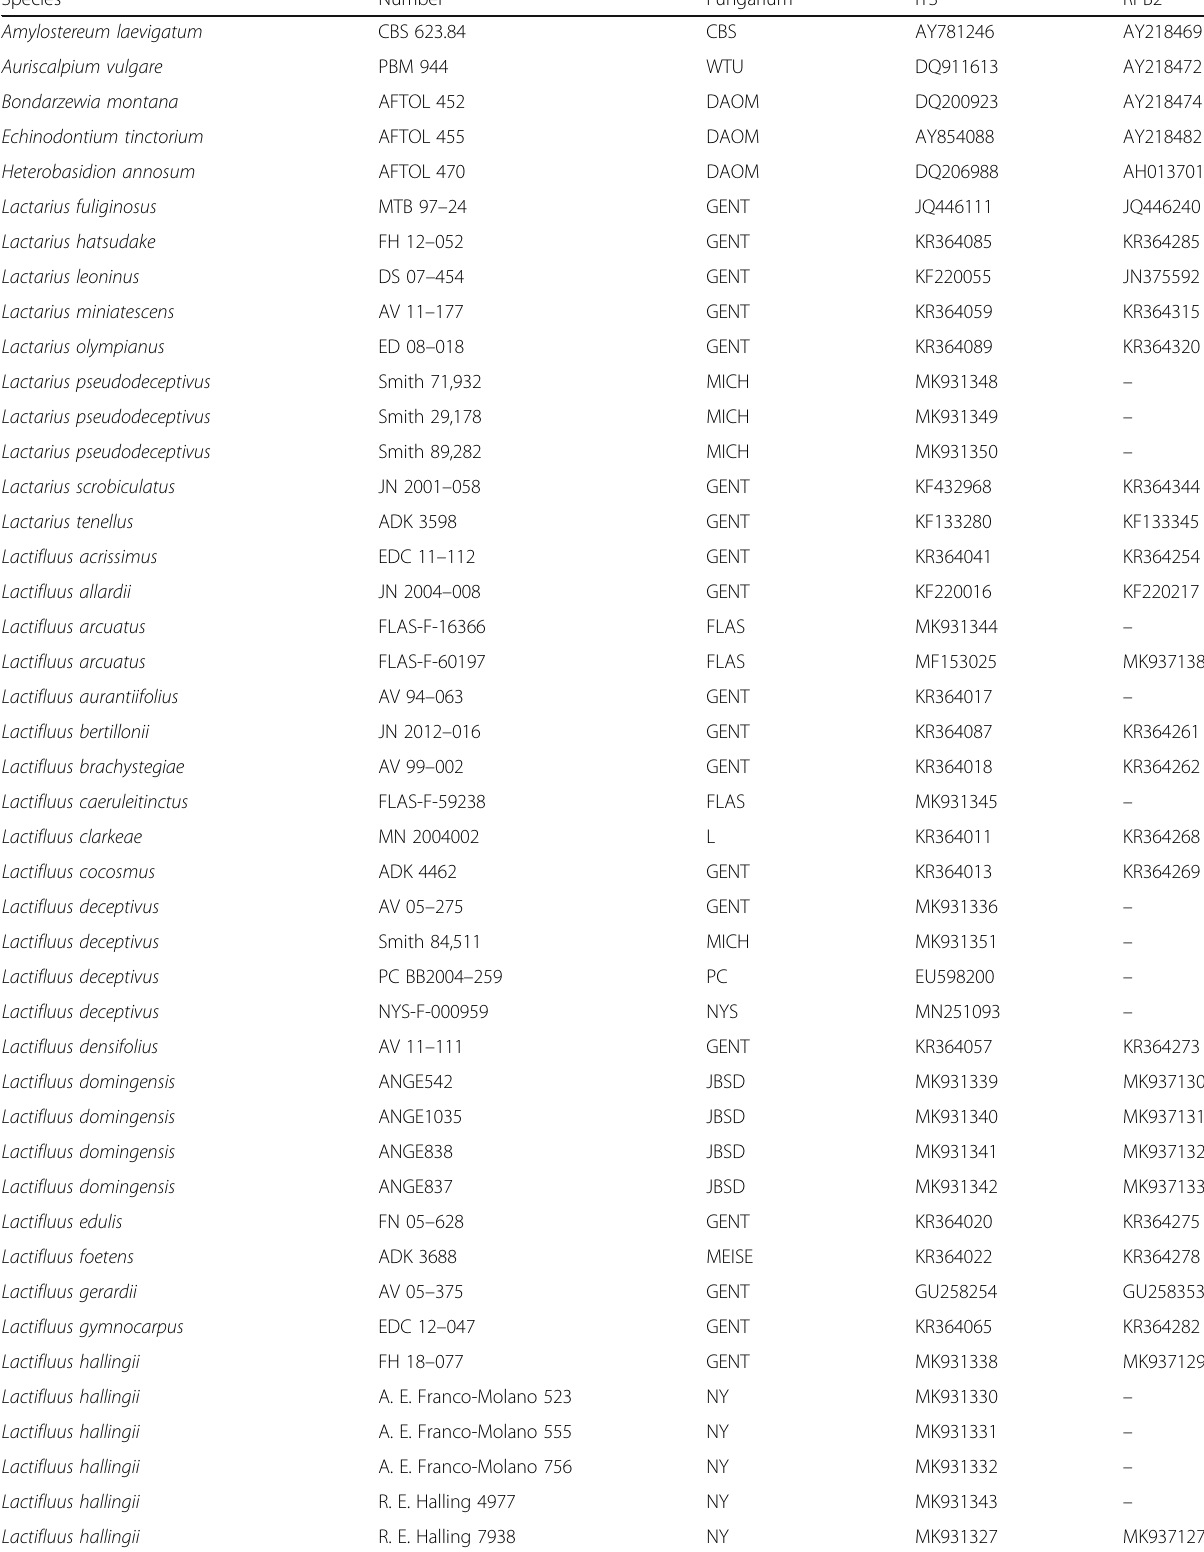
Table 1 Specimens and GenBank accession numbers of DNA sequences used in the molecular analyses